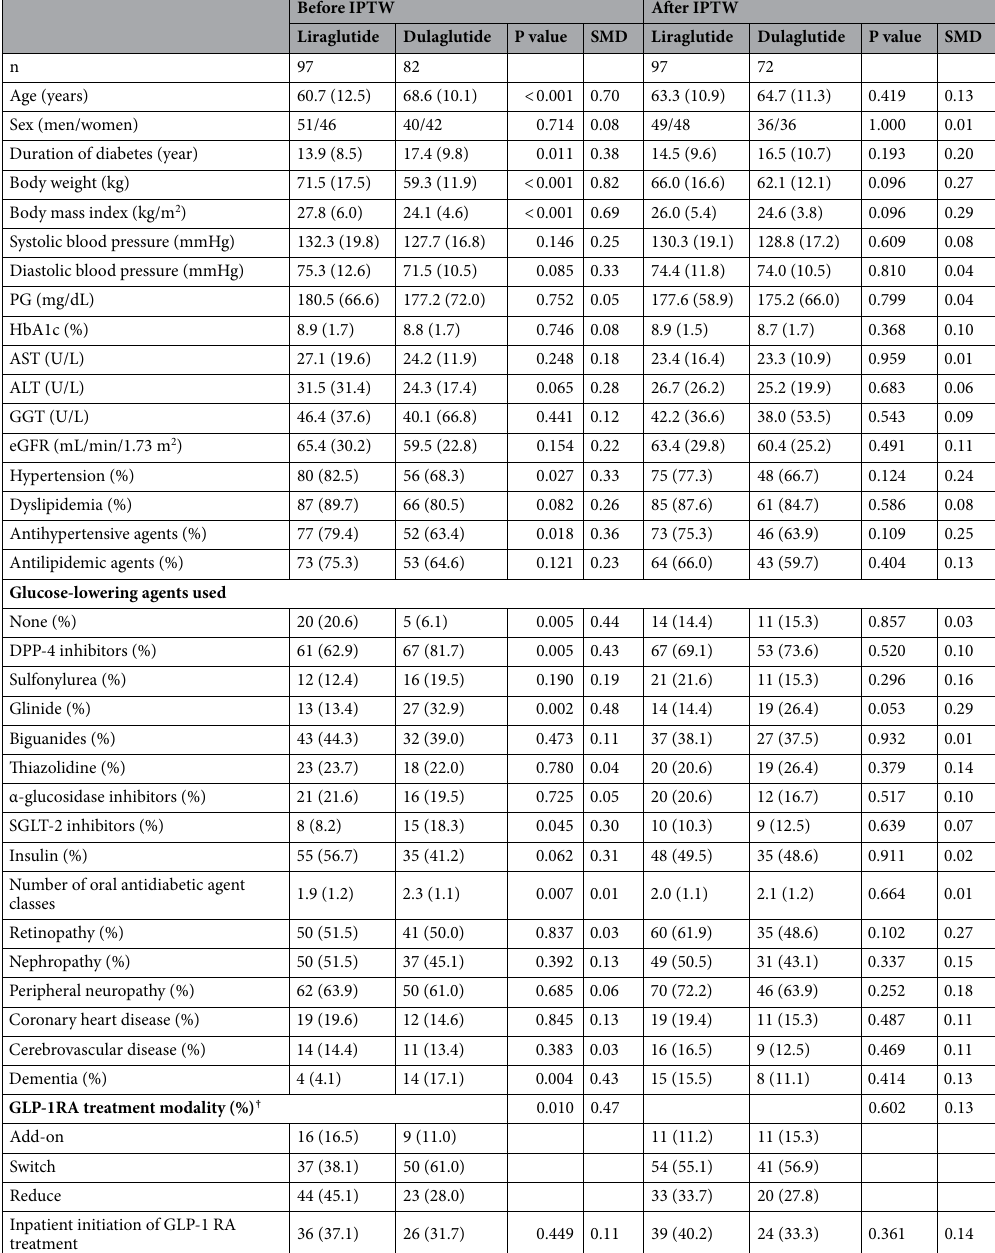
Table 1. Baseline characteristics of the study patients before and after IPTW. Data are mean (standard deviation), or n (%). Comparisons between liraglutide and dulaglutide by the Student’s t -test or Wilcoxon rank-sum test. PG plasma glucose, HbA1c glycated hemoglobin, AST aspartate transaminase, ALT alanine transaminase, GGT gamma-glutamyl transferase, eGFR estimated glomerular filtration rate, DPP-4 dipeptidyl peptidase-4, SGLT-2 sodium-glucose cotransporter 2, GLP-1 RA glucagon-like peptide-1 receptor agonist, IPTW inverse probability of treatment weighting, SMD standardized mean difference. Categorical values were tested by - χ 2 test. P values are for differences between the two groups. † Baseline drug adjustments at liraglutide or dulaglutide initiation were categorized as follows: add-on, when the number of classes of glucose-lowering agents increased; switch, when the number of classes of glucose-lowering agents remained unchanged; reduce, when the number of classes of glucose-lowering agents